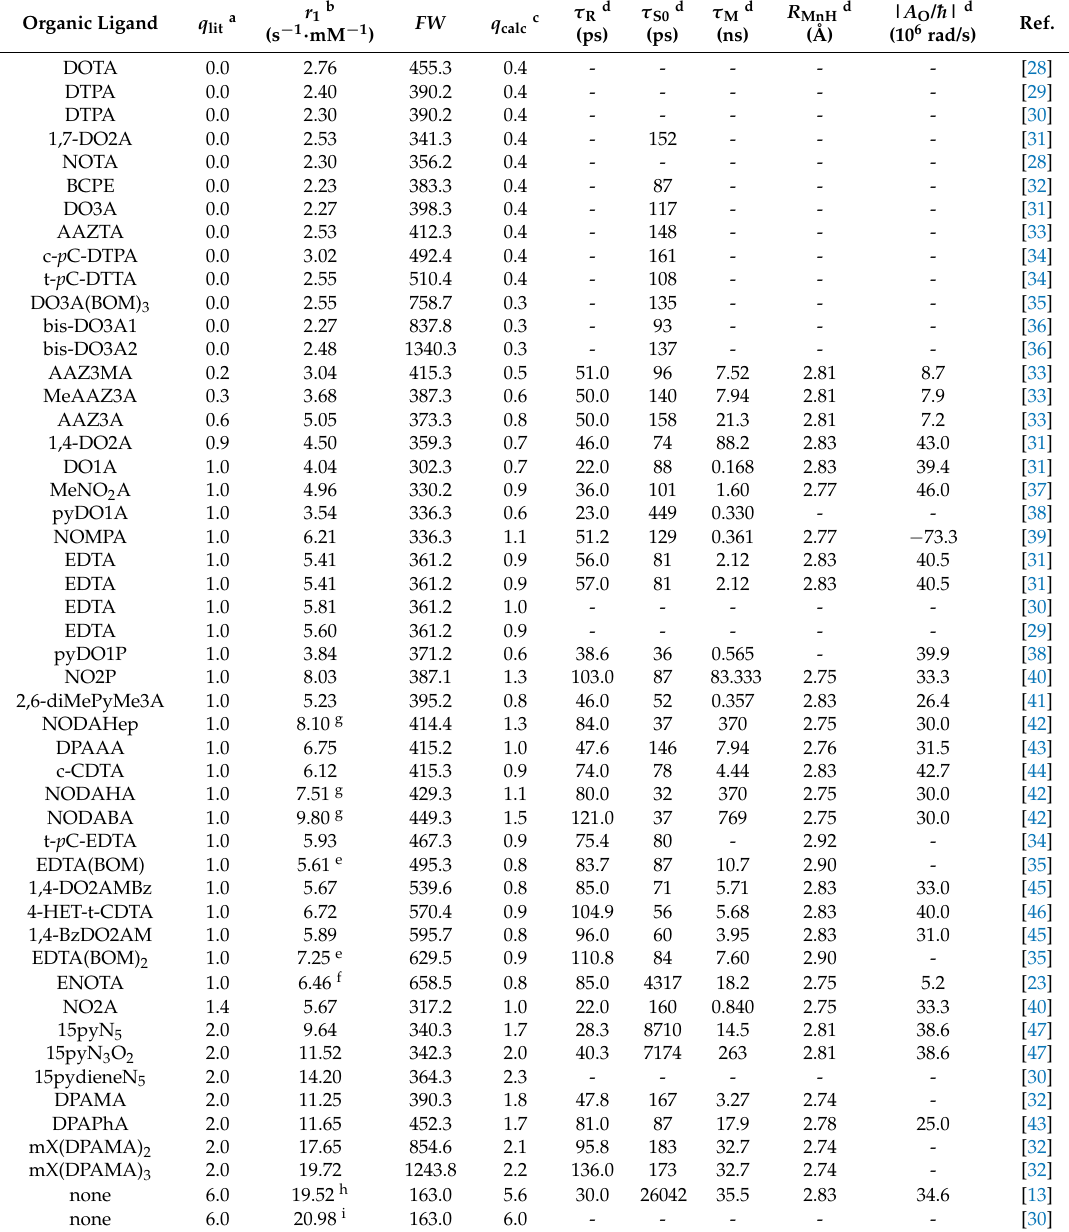
Table 1. Comparison of q lit with q ref as calculated with Equations (11) and (12) for the database of Mn 2+ complexes. Other parameters of relevance for the relaxivity at 298 K and hyperfine coupling constants reported in the literature are